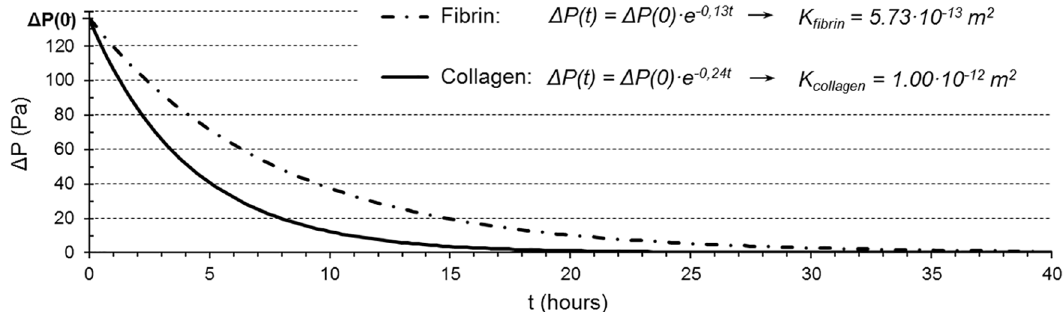
Figure 6. Comparison of the pressure difference drop for both hydrogels. The curves show the pressure difference drop over time for a given initial pressure difference for the collagen and fibrin hydrogels. Compared with collagen, the lower permeability ( K ) of the fibrin results in a slower function decay.